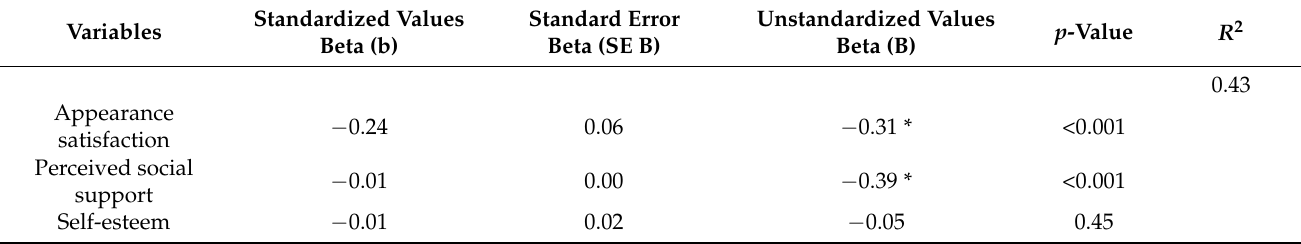
Table 2. Regression analysis for the variables that predict patients’ general level of psychopathology before dermatological treatment.